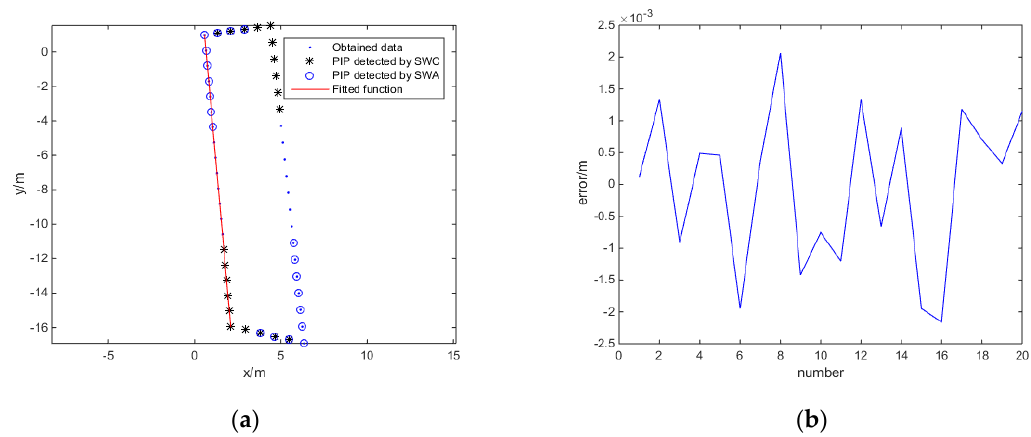
Figure 10. ( a ) Recognition of the straight polygon PCA boundary; ( b ) Bias between the acquired data and corresponding point data on the fitted function.